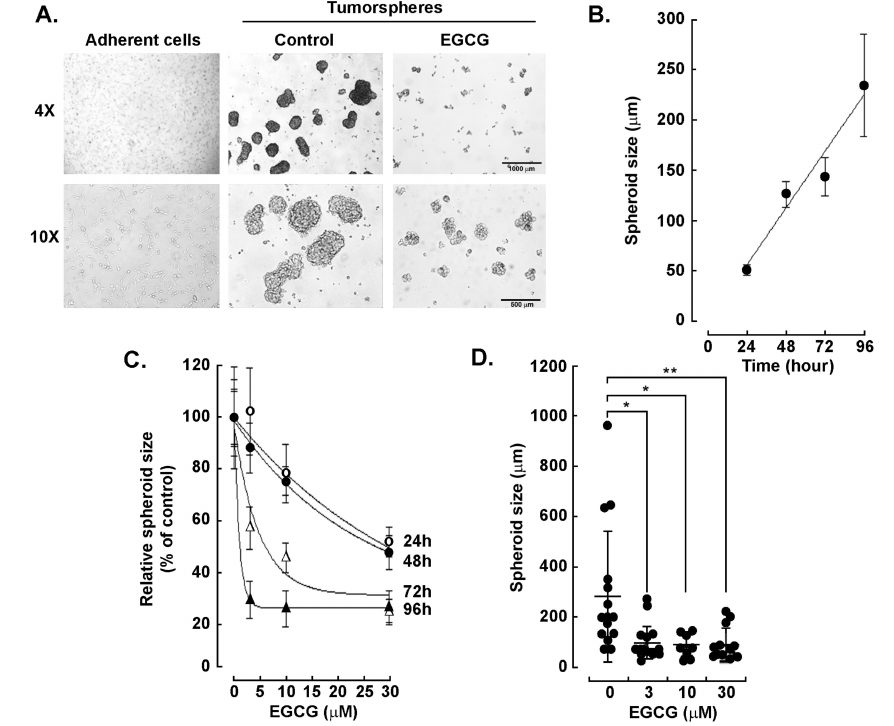
Figure 1. Epigallocatechin-3-gallate inhibits ES-2 ovarian clear cell carcinoma tumorsphere formation. ( A ) Tumorspheres were generated from adherent human ES-2 ovarian cancer cell monolayer cultures, as described in the Methods section, in the absence or presence of 30 µ M EGCG. Representative phase contrast pictures were taken at 96 h at 4 × (upper panels) and 10 × (lower panels) magnification. The spheroid formation and growth were monitored under an inverted phase-contrast microscope, and the size of the spheroids was measured from at least three independent experiments. Representative tumorsphere images are shown. ( B ) Relative spheroid perimeter was measured at the indicated time, and tumorsphere growth kinetic assessed for up to 96 h. ( C ) Tumorspheres growth was performed for the indicated times and in the presence of increasing EGCG concentrations. ( D ) Statistical analysis of tumorspheres growth at 96 h in the presence of increasing EGCG concentrations. All experiments were performed in triplicate and repeated three times, data were analyzed using one-way analysis of variance, and the results were expressed as mean ± SD (* p < 0.05; ** p <